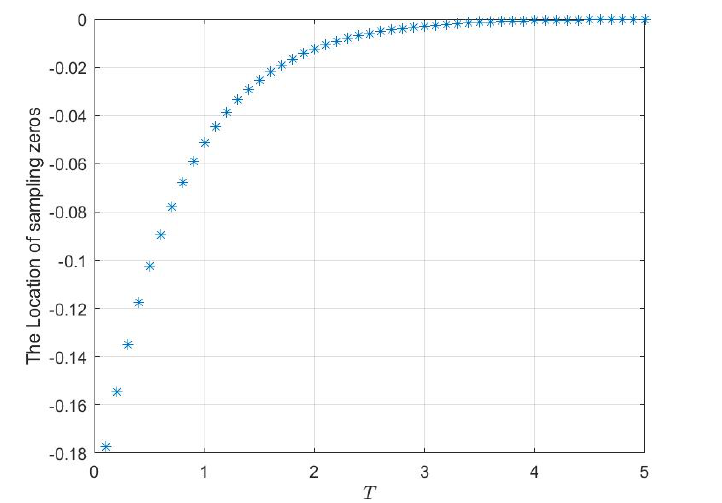
Figure 3. The different asymptotic properties of the sampling zero of a sampled-data model with different fixed T and not fixed N when using ABTSH with f = 0.35.